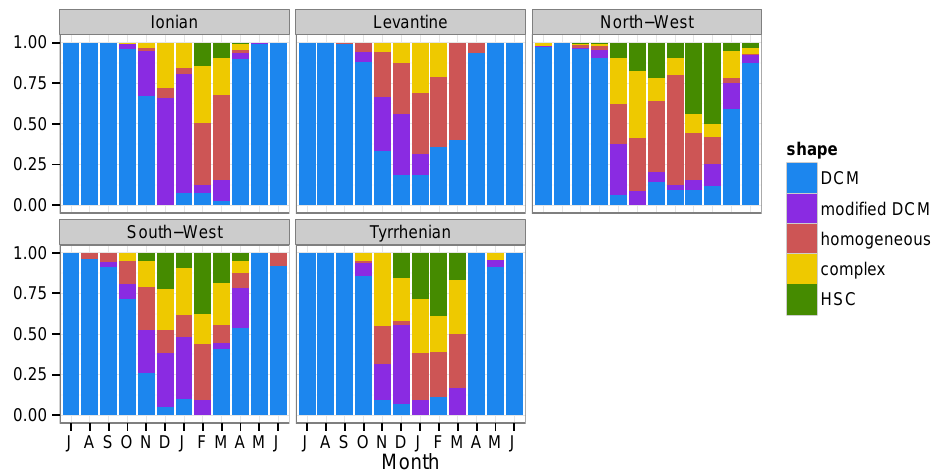
Figure 5. Histograms indicating for each month and each Mediterranean region the proportion of each type of standard shape observed in the 1994–2014 database (i.e., DCM , homogeneous , HSC , modified DCM and complex ; see Fig. 2 and Sect. 2.3). The height of color bars indicates the proportion of profiles which were classed in each category of standard shapes. Note that months range from July to June.